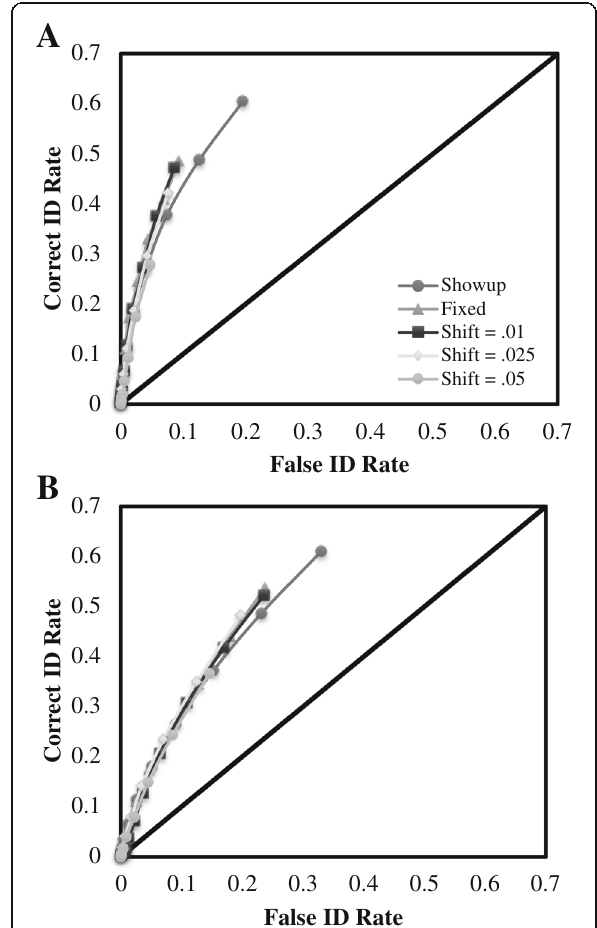
Fig. 6 Criterion shift: receiver operating characteristic (ROC) curves comparing showups and 6-person lineups, with decision criterion fixed or allowed to shift + .01, + .025, and + .05, if two or more lineup members ’ match values fell above csim . a Fair lineup, SSF = SSP =.6. b Biased lineup, SSF =.5, SSP =.75. SSP Similarity of the innocent Suspect to the PERP, SSF Similarity of the Suspect to the Fillers, PERP